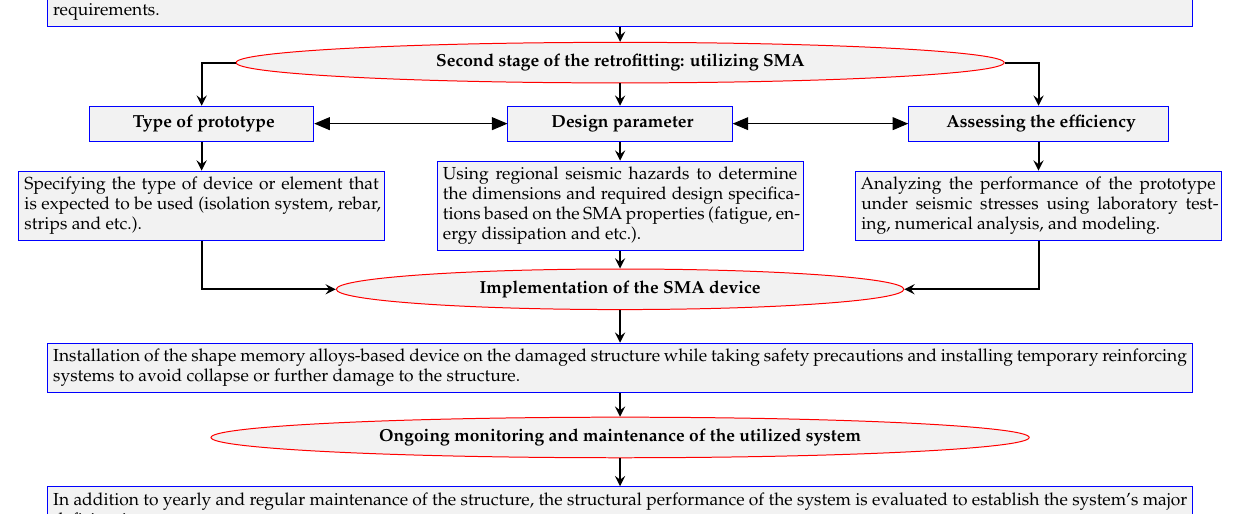
Figure 18. Proposed algorithm of retrofitting of the masonry structures with implementation of SMA-based